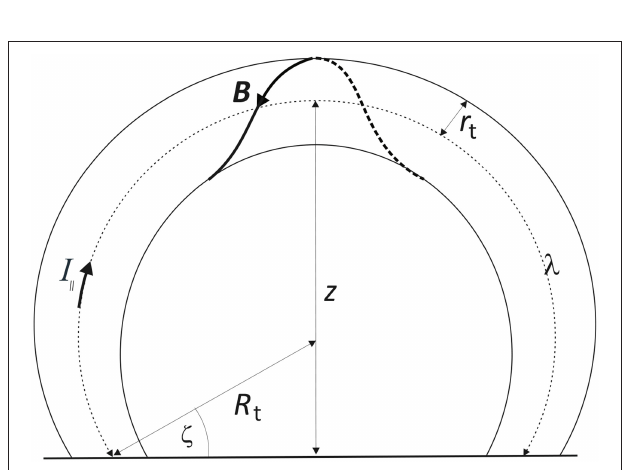
FIGURE 3 | Schematic presentation of a semi-toroidal flux-rope geometry. For details see the main text.